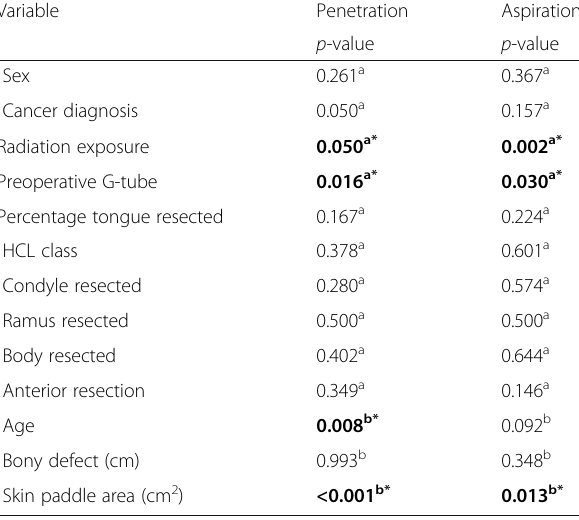
Table 4 Predictors of aspiration and penetration on early Videofluoroscopic test Table 5 Clinical predictors for long-term functional